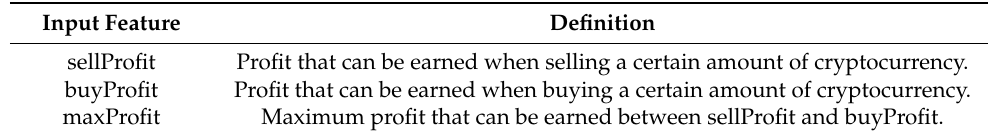
Table 2. Definition of sellProfit, buyProfit, and maxProfit.